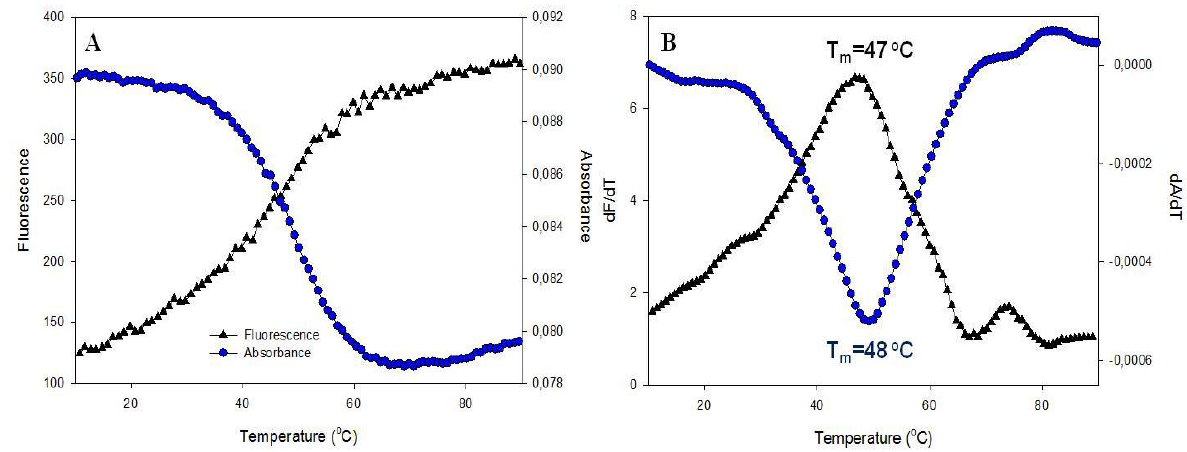
Figure 4. Comparison of melting curves ( A ) obtained for ChF19T by monitoring changes in absorbance at 295 nm (circles, blue line) and in fluorescence of FAM (triangles, black line), measured in 10 mM cacodylate buffer, pH 7.5 containing 100 mM KCl, 1 μM strand concentration. First derivatives of the melting data are shown in panel ( B